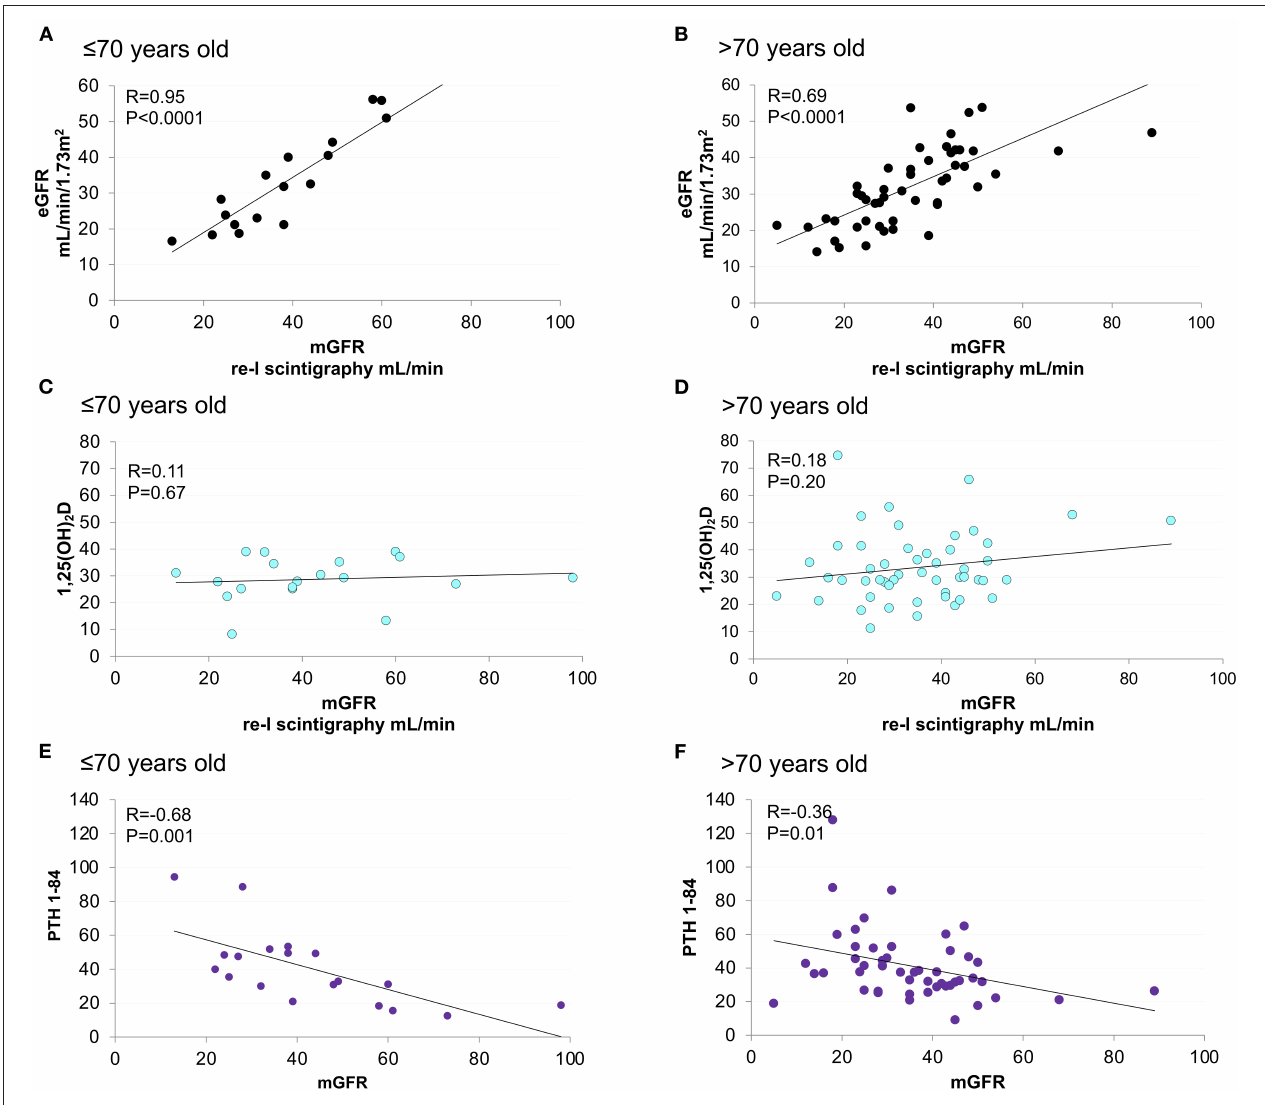
FIGURE 3 | Linear correlation between mGFR and eGFR, 1,25(OH)2D and PTH (1–84), stratified according to age. Age < = 70 years old figures (A,C,E) . Age > 70 years old figures (B,D,F) .